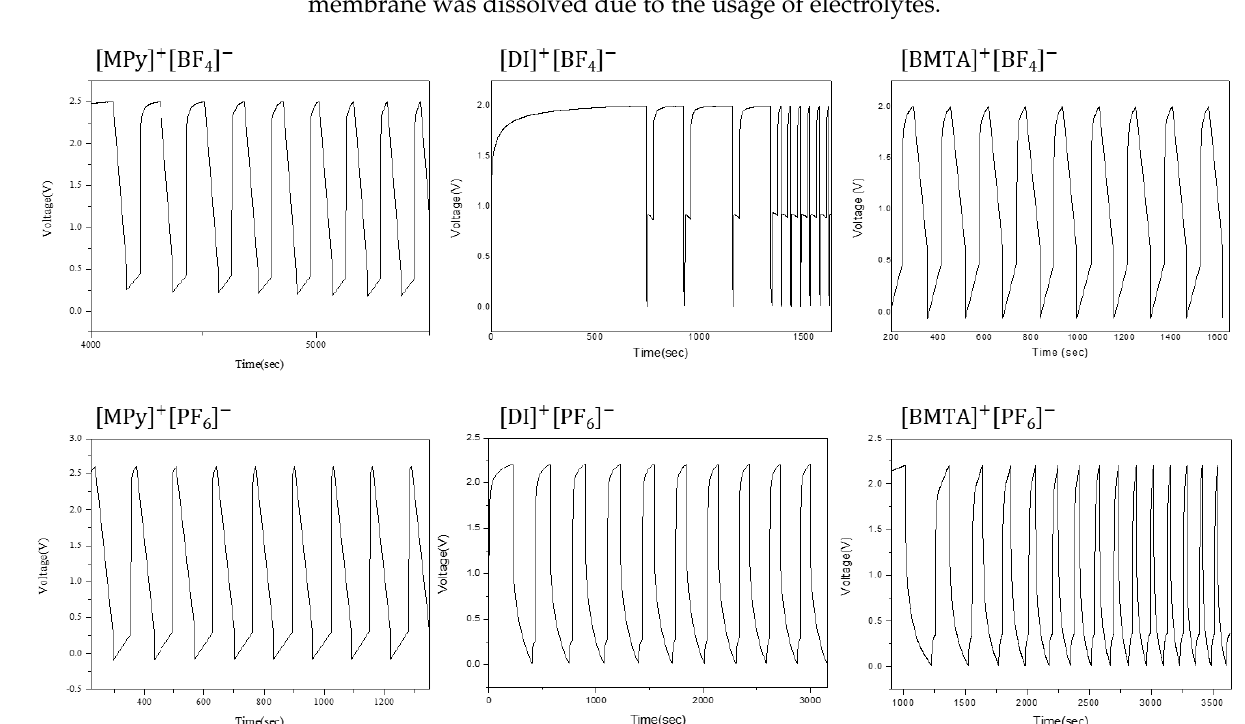
Figure 5. Electrochemical capacitor performance of 0.1M V(acac) 3 in acetonitrile in the presence of 0.1 M N-heterocyclic aromatic salts (Working condition: set voltage = 2.5 V, I c = 0.1 mA, and I d = − 0.1 mA, Neosepta ® AFN).